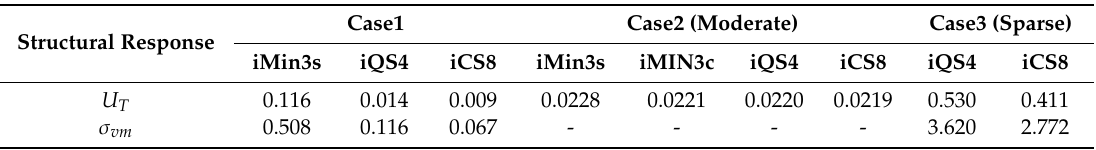
Table 1. Root–mean–square di ff erence (RMSD) results for U T displacement and σ vm stress of various test